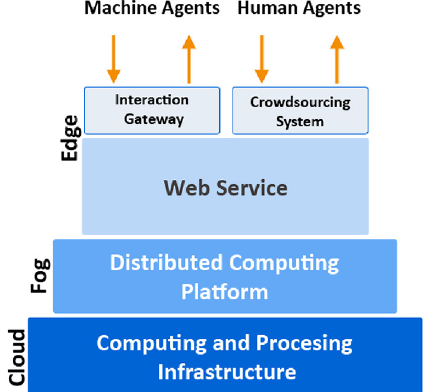
Figure 8. Layered architectural representation of